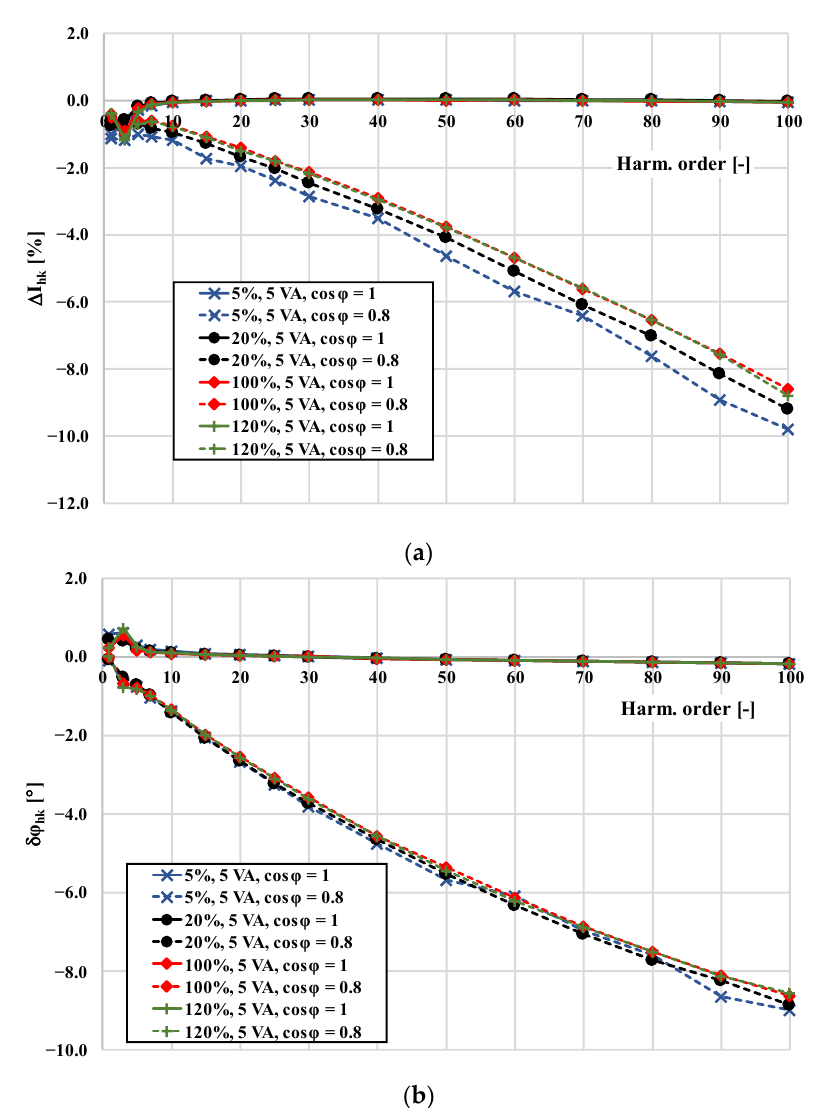
Figure 4. Comparison of the influence of the secondary winding rated load with power factor 0.8 inductive and 1.0 of a 300 A/5 A CT on: ( a ) current error; ( b ) phase displacement.